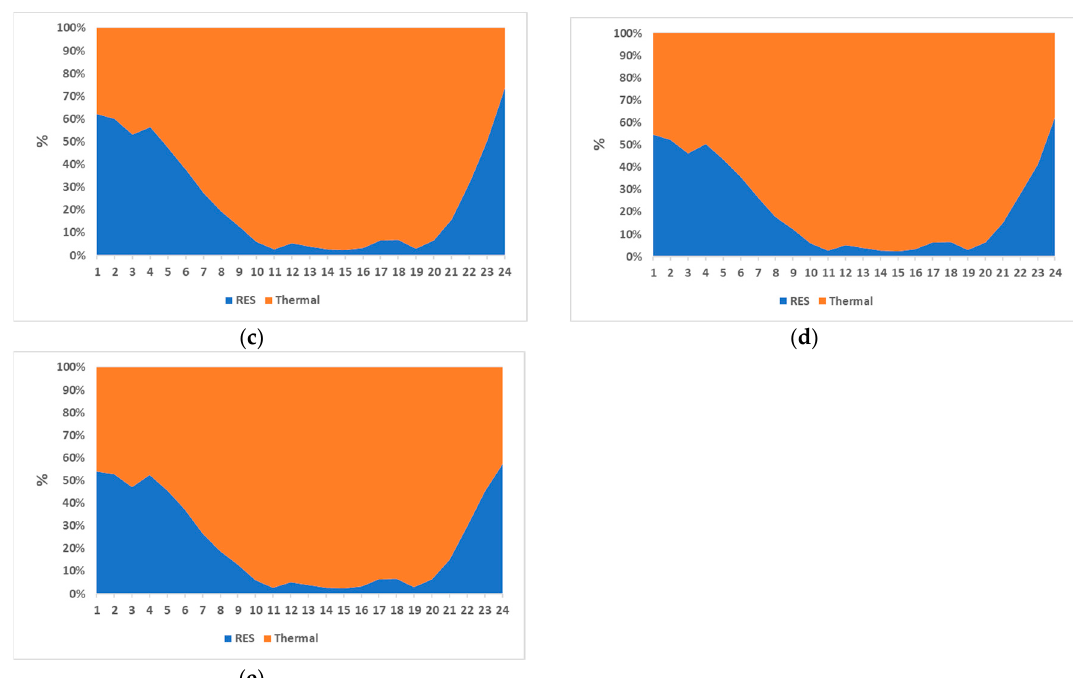
Figure 7. Evolution of hourly energy mix (in %) of the examined typical day for the ( a ) RUC_BAS, ( b ) RUC_Cyber1, ( c ) RUC_Cyber2, ( d ) RUC_Cyber3, and ( e ) RUC_Cyber4 scenarios.